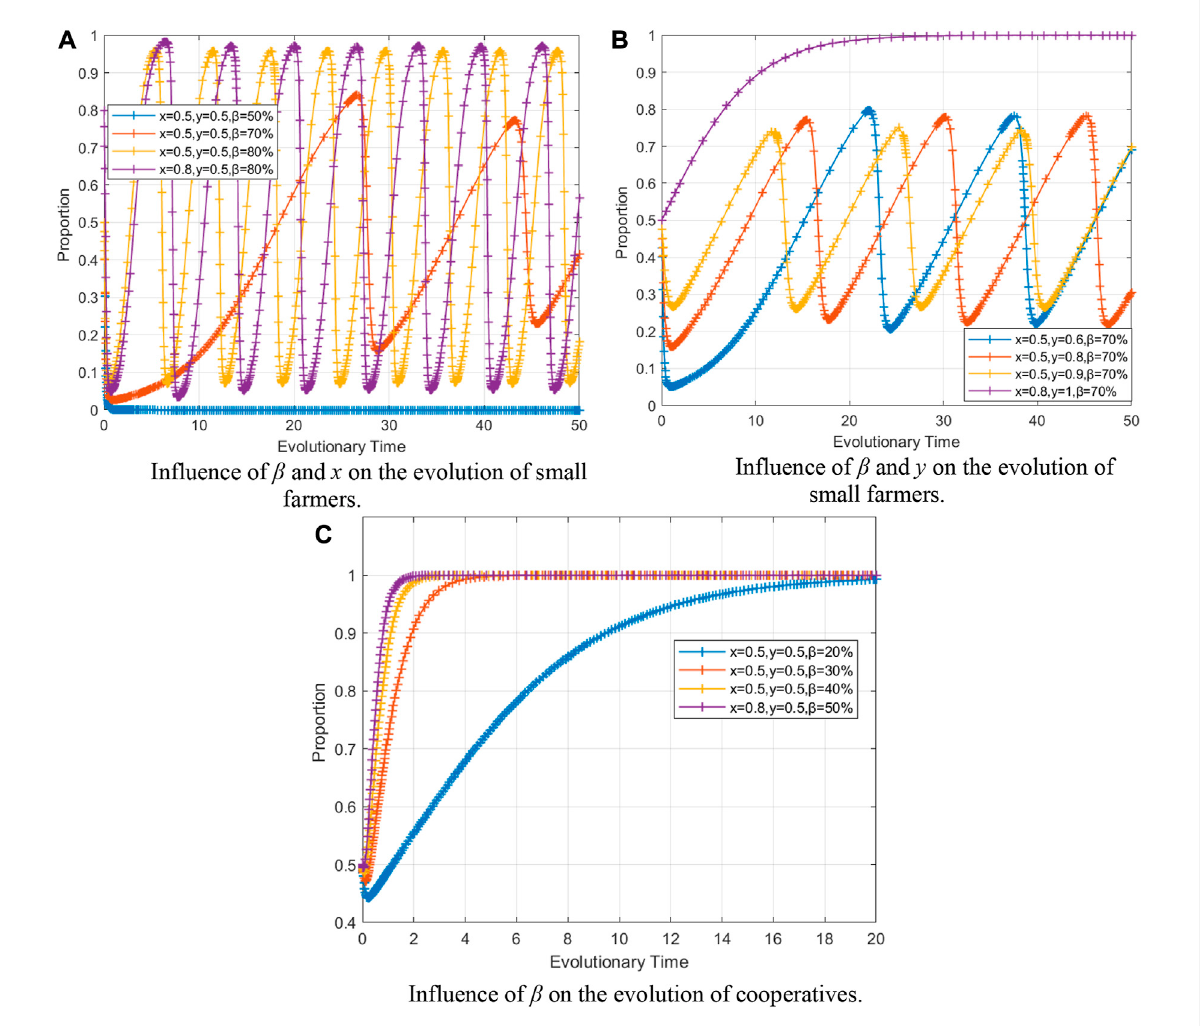
FIGURE 10 (A) In fl uence of β and x on the evolution of small farmers. (B) In fl uence of β and y on the evolution of small farmers. (C) In fl uence of β on the evolution of